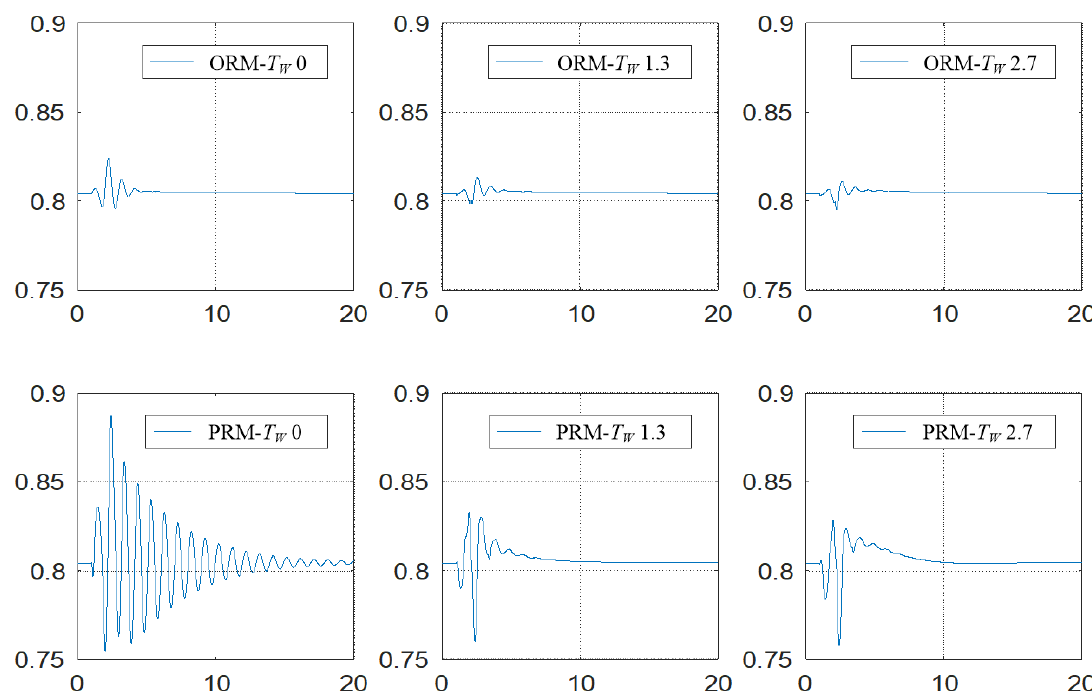
Figure 8. Response of hydroturbine output torque m t under three-phase short circuit.